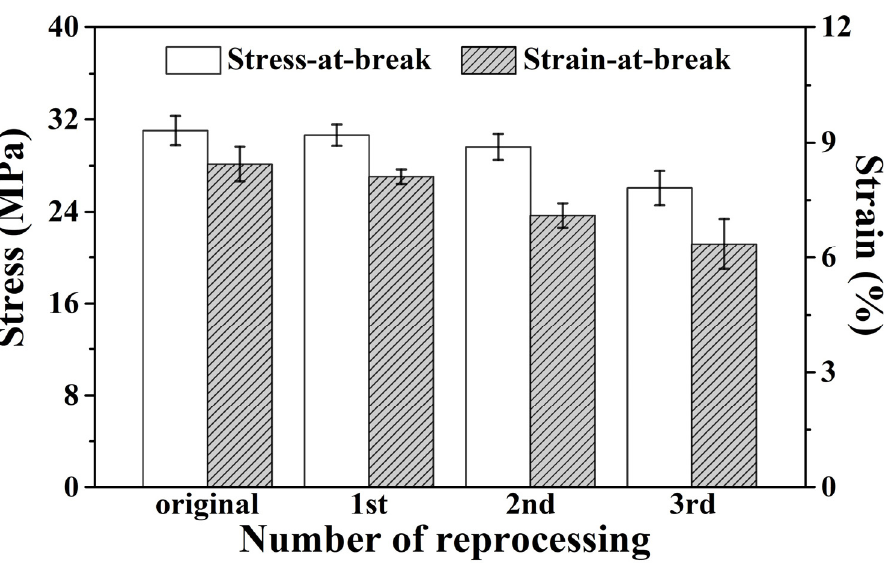
Figure 6. Tensile performances of the original and reprocessed OBZ-BDB.